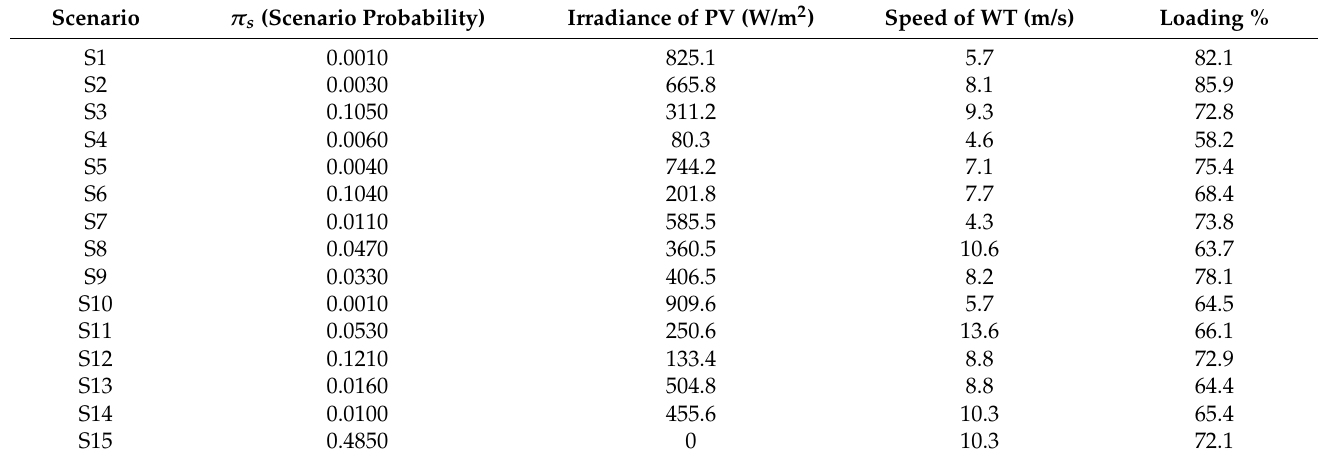
Table 1. Reduced created scenarios, with associated